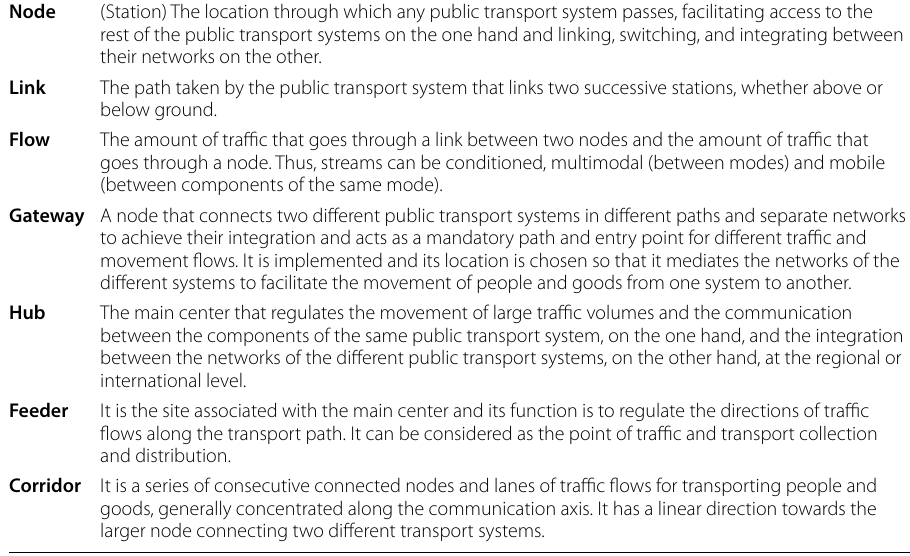
Table 1 The main structural components of transport